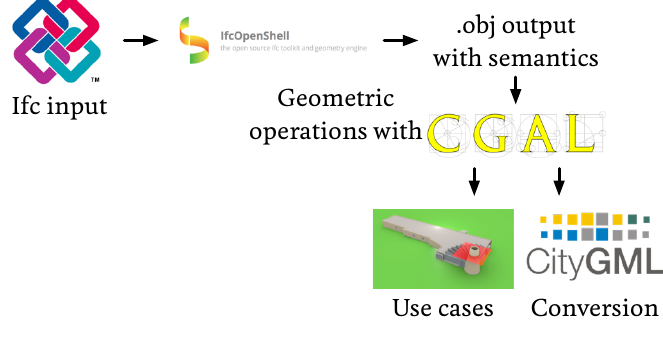
Figure 8. The final